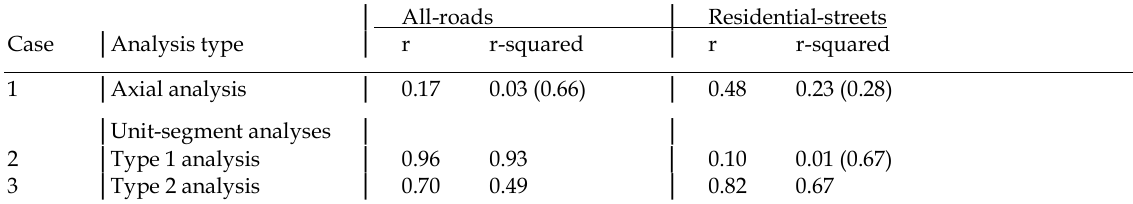
Table 2. Integration-movement correlations